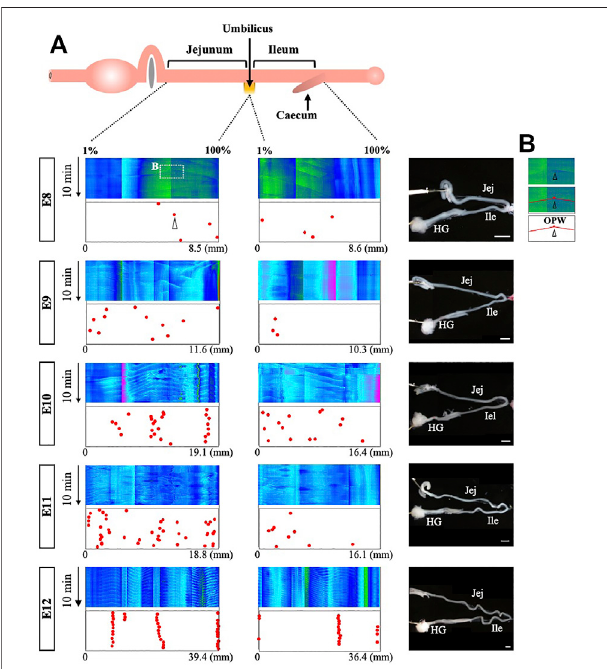
FIGURE 2 | Distribution map of origins of bidirectional waves during gut development. (A) In the kymographs, the locations of apices are plotted to preparethemapoforigins.Foreachstage,fourembryoshavebeenassessed and one of these is shown in this fi gure, whereas the other three are shown in Supplementary Figure S2 . The locations of the origins are plotted in the jejunum and ileum. Since the length of the gut differs between individuals, the locations are normalized (1% – 100%) relative to the length of each region(seetextsfordetails).WhileoriginsarerandomlydistributedatE8, they become con fi ned to speci fi c regions by E12. (B) The square indicated in the kymograph of E8 is enlarged to show the apex with v-shaped lines. Scale bars: 2